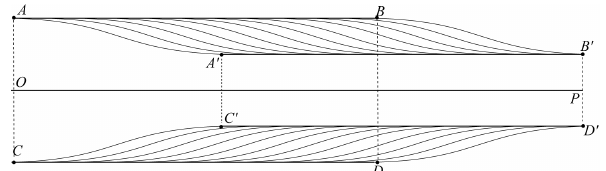
Figure 1. Sound wave in a medium undergoing compression (see